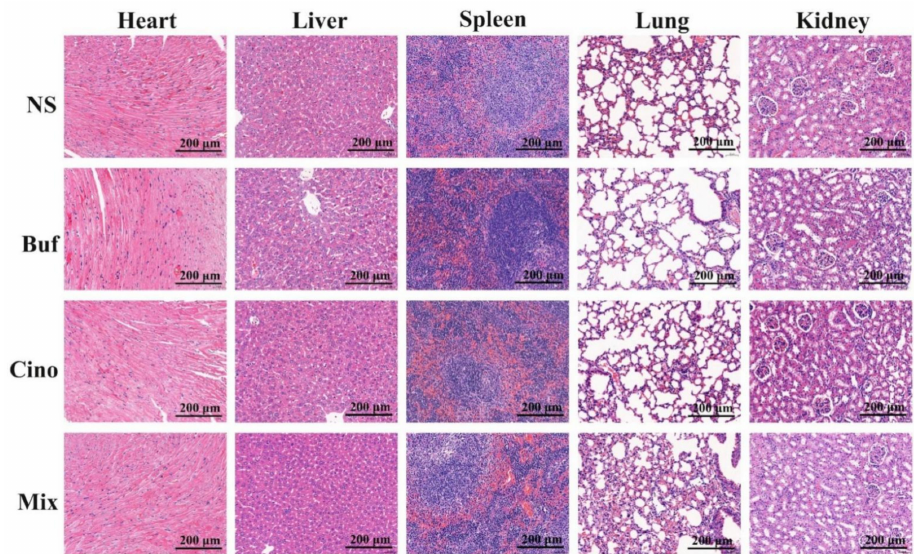
Figure 5. H&E staining analysis of major organs (heart, liver, spleen, lung, kidney) of HepG2 tumor-bearing nude mice model after 20 days’ drug intervention (original magnification: 200 × ).